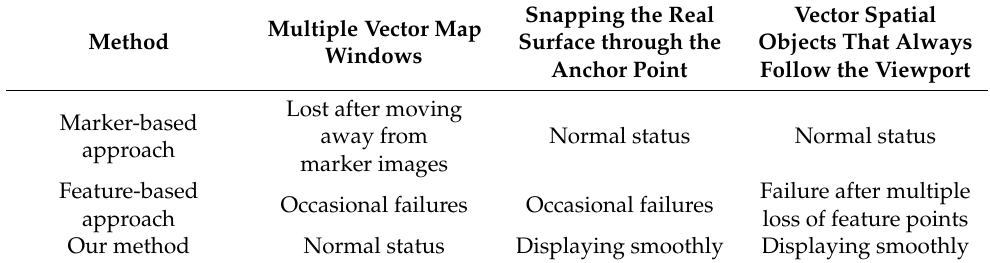
Table 6. Rendering results comparison of all methods in